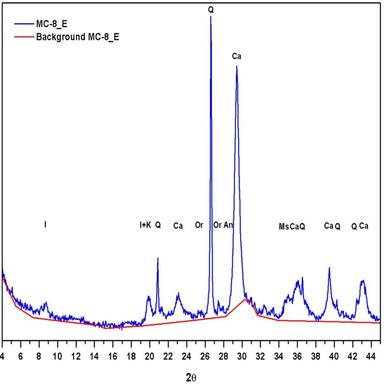
Diffractogram of MC-8_E sample. Elevation of the background in the diffuse range between 19 and 31 2h indicating the presence of amorphous material.